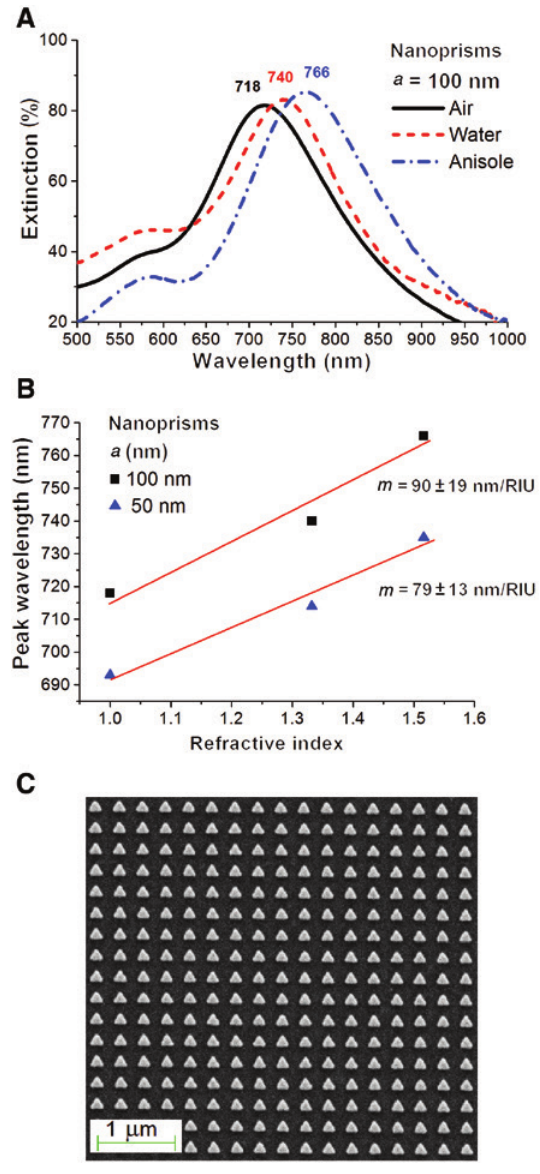
Figure 4: Extinction spectra of a periodic nanopattern based on nanoprisms with d = 180 nm and a = 100 nm (A). Trends of the LSPR peak wavelength versus the refractive index of the medium achieved for the nanoprisms array with a = 50 nm and a = 100 nm (B). SEM image of the nanoprisms pattern with a = 100 nm